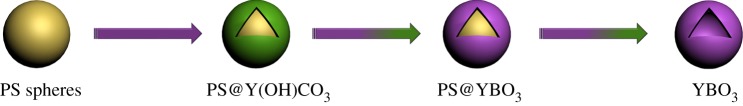
Schematic of the synthesis route of the YBO3 hollow microspheres.